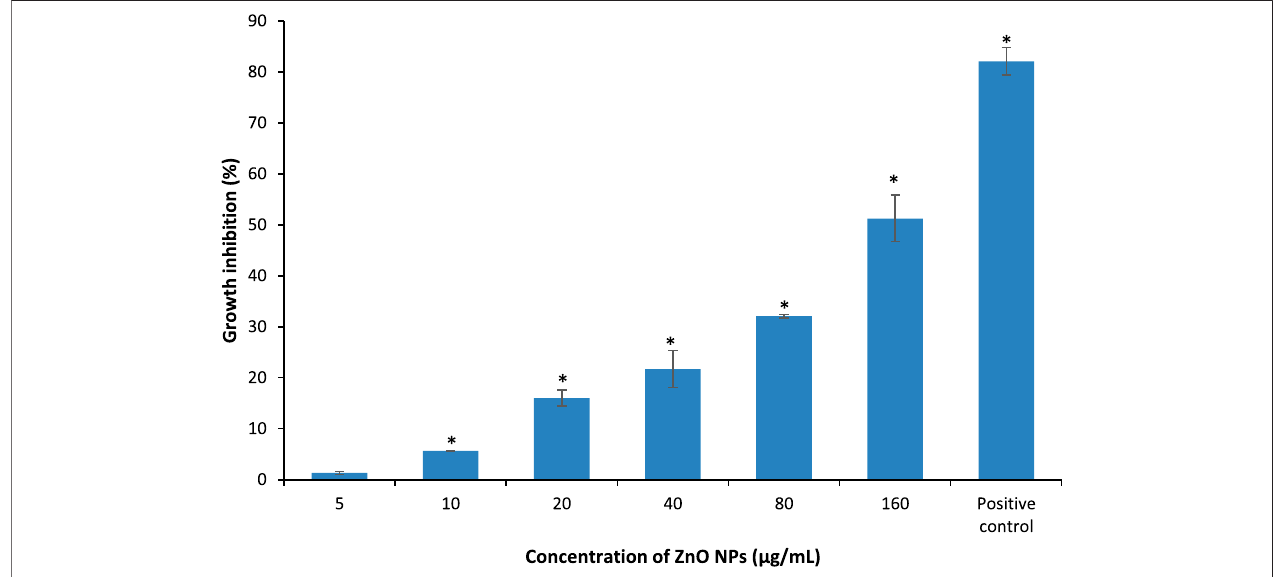
FIGURE 4 | Percentage of growth inhibition of S. marcescens after treatment with different concentrations of ZnO NPs for 24 h at 37 ° C in LB broth. * denotes the signi fi cant difference between the negative control and the bacterial suspension treated with different concentrations of ZnO NPs at p < 0.05.